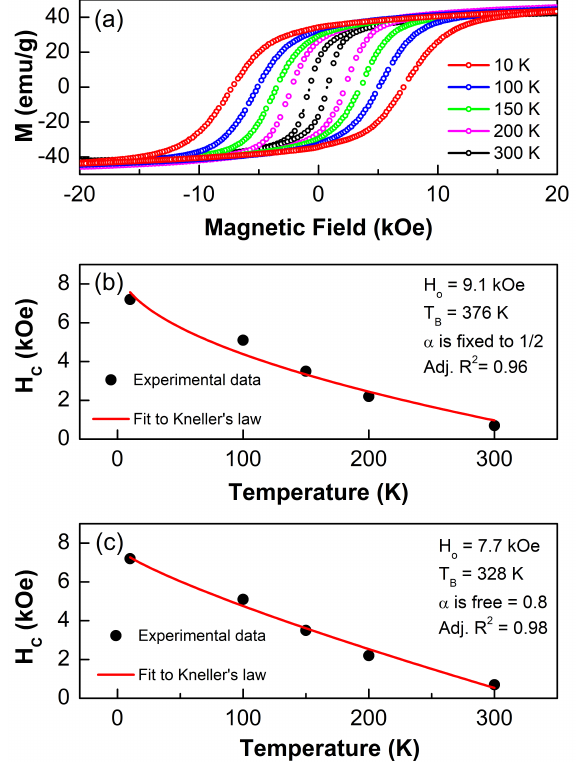
Figure 4. ( a ) Magnetization curves of the Cu 0.75 Co 0.25 Fe 2 O 4 ferrite nanoparticles recorded at different temperatures. ( b ) “ H c ( T ) data fitted to the original Kneller’s law with a fixed Kneller’s exponent ( α = 1/2). ( c ) H c ( T ) data fitted to the modified Kneller’s law with a free Kneller’s exponent ( α =